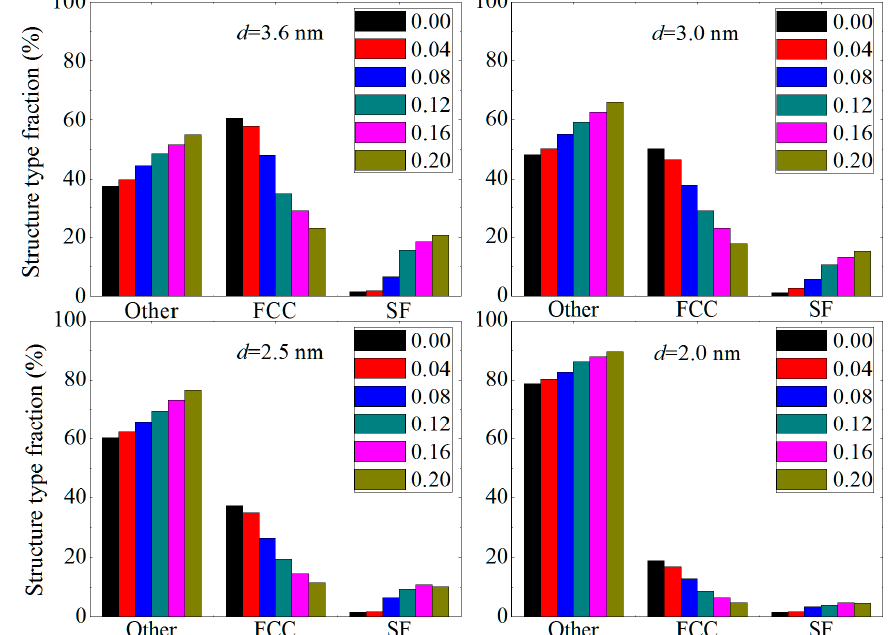
Figure 4. The structure type fraction of CoCrFeNiMn with different mean grain sizes under uniaxial tension strain. The FCC, SF and other represents the face-centered cubic, stacking fault and amorphous structure, respectively.